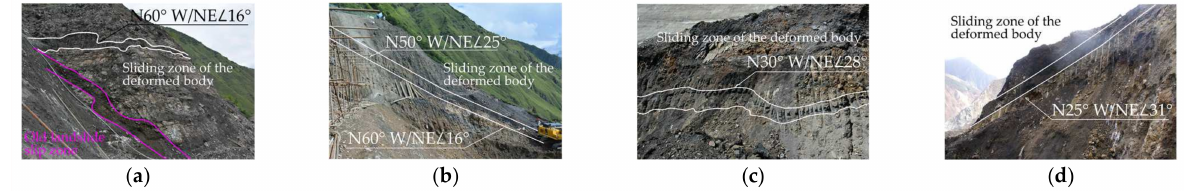
Figure 13. Sliding zone characteristics of a deformation body in Danbo reservoir: ( a ) Slip zone at 2330 m elevation; ( b ) Slip zone at 2340–2370 m elevation; ( c ) Slip zone at 2350 m elevation; ( d ) Slip zone at 2410 m